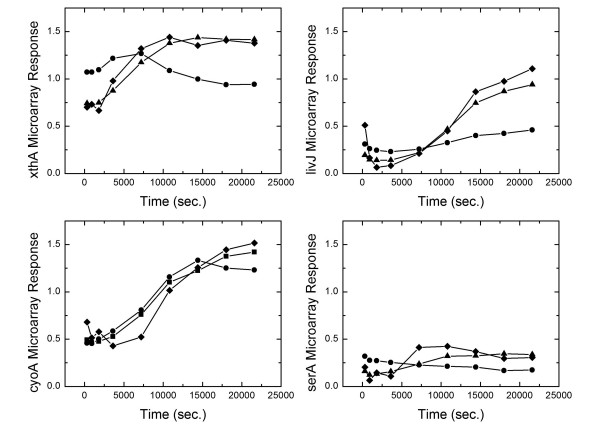
The predicted microarray response of xthA, livJ, cyoA and serA is enhanced after adding interactions suggested from promoter sequence analysis. Diamonds indicate the experimental microarray response; Circles indicate the predicted microarray response before adding the suggested interactions; Triangles indicate the predicted microarray response after adding the suggested interactions